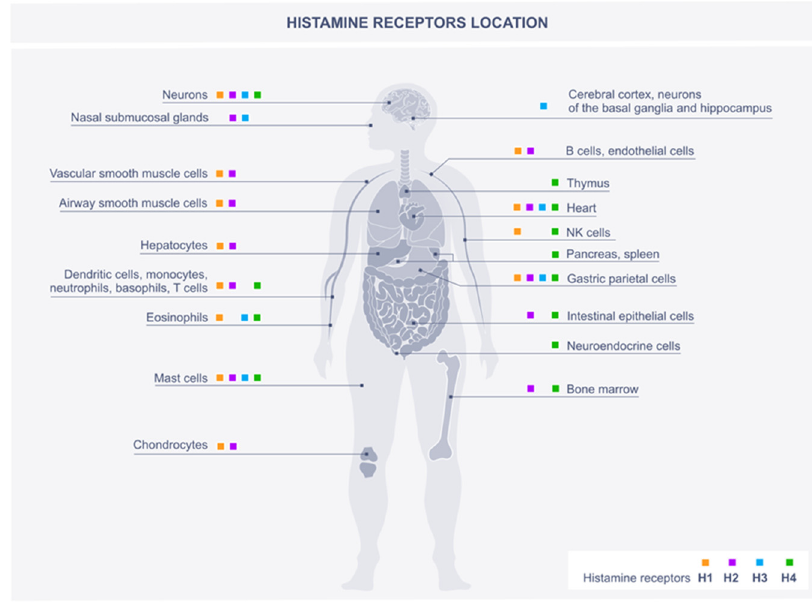
Figure 1. The location of histamine receptors in the human body.